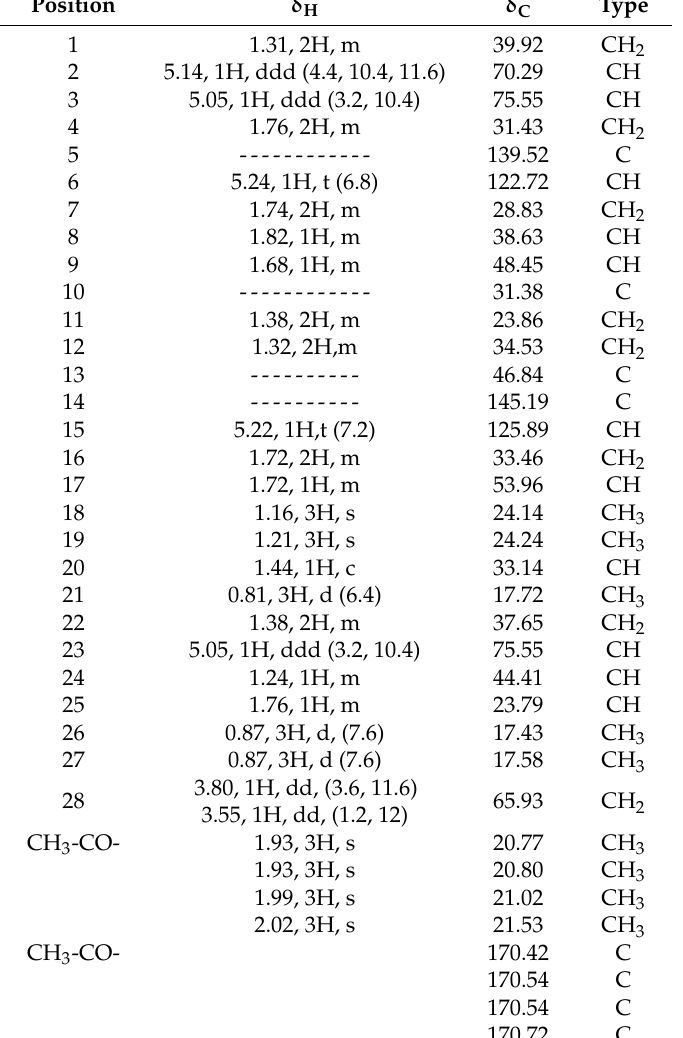
Table 2. 1 H (400 MHz) and 13 C (100 MHz) NMR data for compound 3a (acetone- d 6